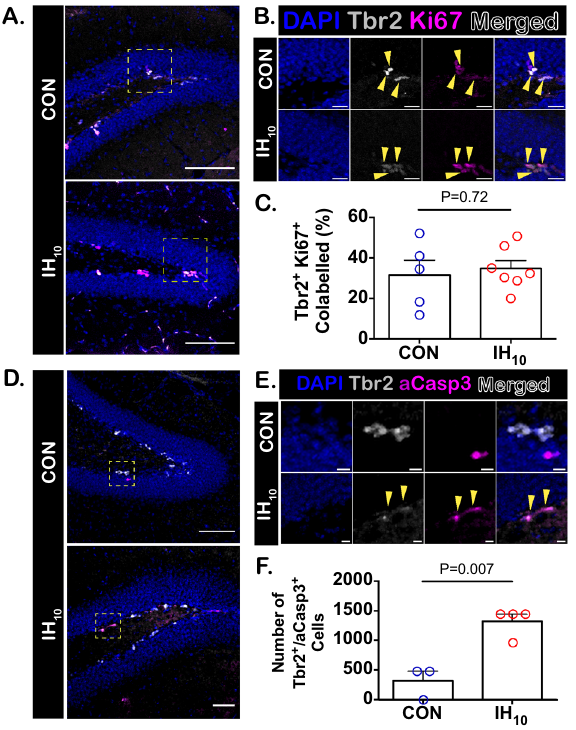
Figure 4. While IH 10 does not enhance proliferation among Tbr2 + cells, activated caspase-3 expression is enhanced among Tbr2 + cells by IH 10 . ( A ) Representative images of the dentate gyrus from CON and IH 10 show similar labeling for Ki67 + and Tbr2 + cells (CON: n = 5, IH 10 : n = 7). Scale bars are 100 μm. ( B ) Magnified images from yellow dashed boxes in ( A ) from CON and IH 10 . Yellow triangles denote co-labelling among cells. Scale bars for inset images are 20 μm. C. No difference between co-labeling of Tbr2 + /Ki67 + cells suggesting IH 10 does not impact proliferative activity among Tbr2 + cells. ( D ) Representative images of the dentate gyrus from CON and IH 10 treated animals showing the labeling for activated capase-3 + and Tbr2 + cells (CON: n = 3, IH 10 : n = 4). ( E ) Magnified images from yellow dashed boxes in ( D ) from CON and IH 10 . Yellow triangles denote co-labeling among cells. Scale bars for inset images are 20 μm. F. Co-labeling of Tbr2 + /activated capsase-3 + cells is greater in CON compared to IH 10 (P = 0.007) indicating that IH 10 activates apoptosis among Tbr2 +